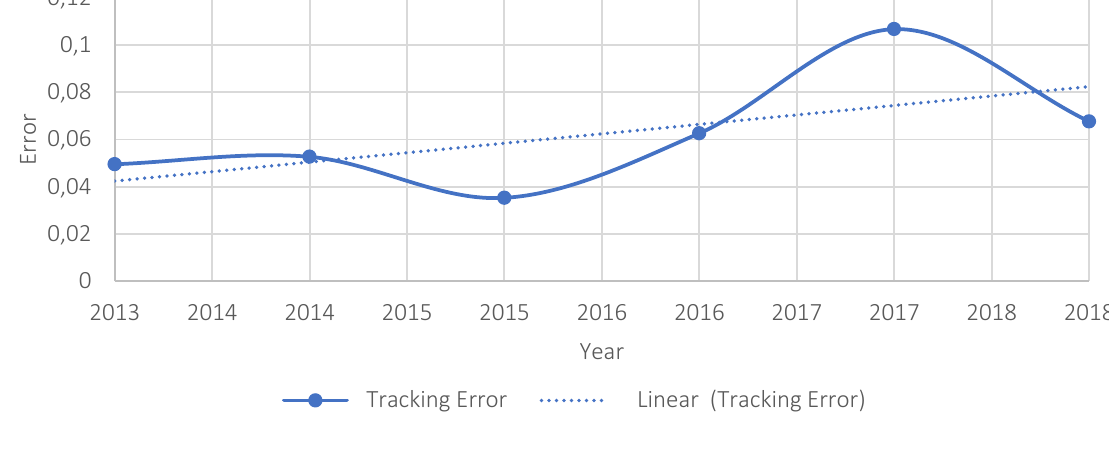
Figure 2. Tracking error